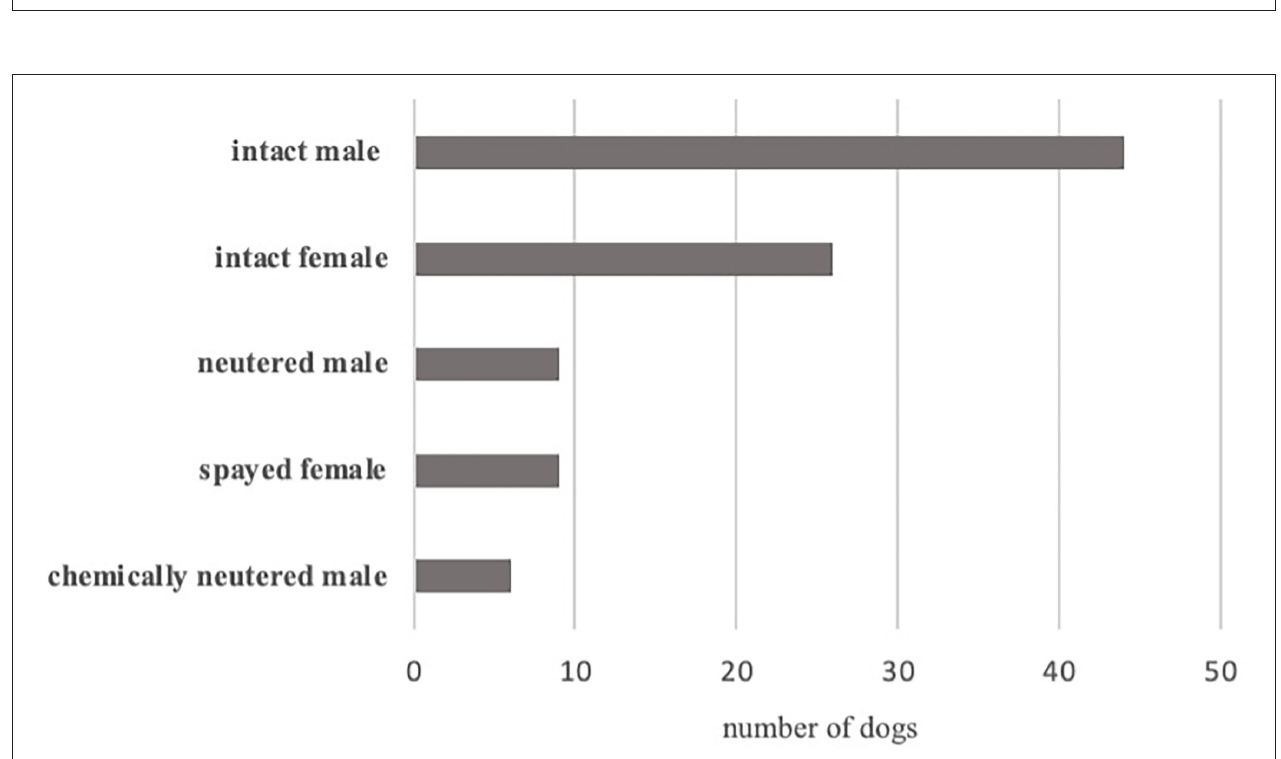
FIGURE 2 | Distribution of sex of Great Swiss Mountain Dogs with idiopathic epilepsy, whole study population.